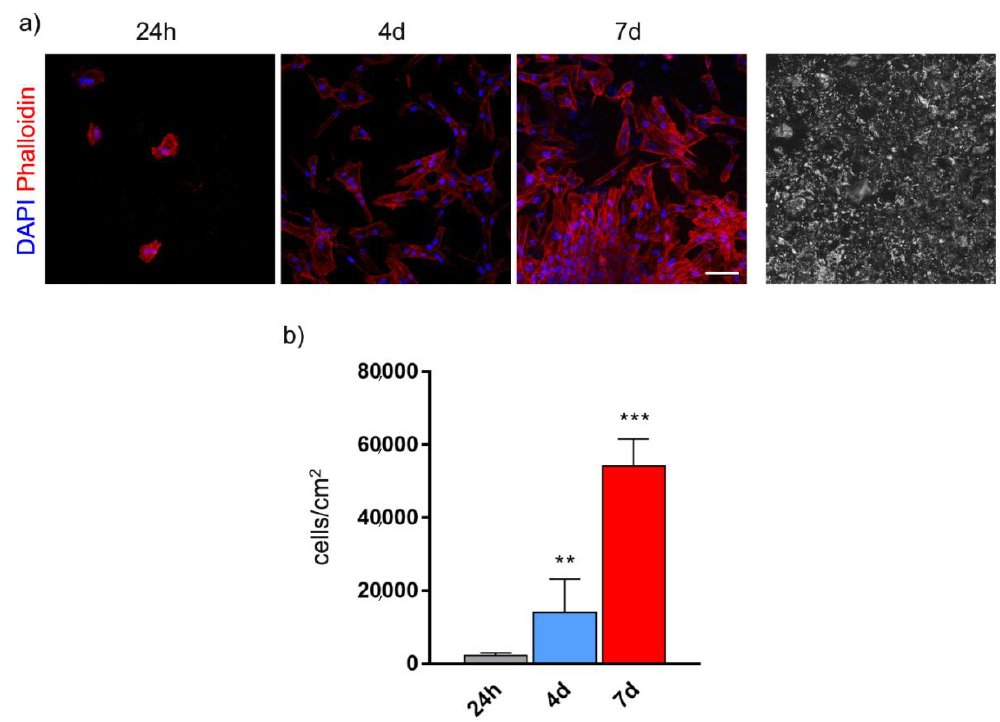
Figure 3. Cell morphology ( a ) and proliferation ( b ) of human dental pulp stem cells (hDPSCs) cultured on BGMS10 surfaces at di ff erent time points. Immunofluorescence analysis shows representative images of hDPSCs at 24 h, 4 days and 7 days. On the right, BGMS10 surface is shown. ** p < 0.01 vs. 24 h, *** p < 0.001 7 days vs. 4 days and vs. 24 h. Scale bar: 50 µ